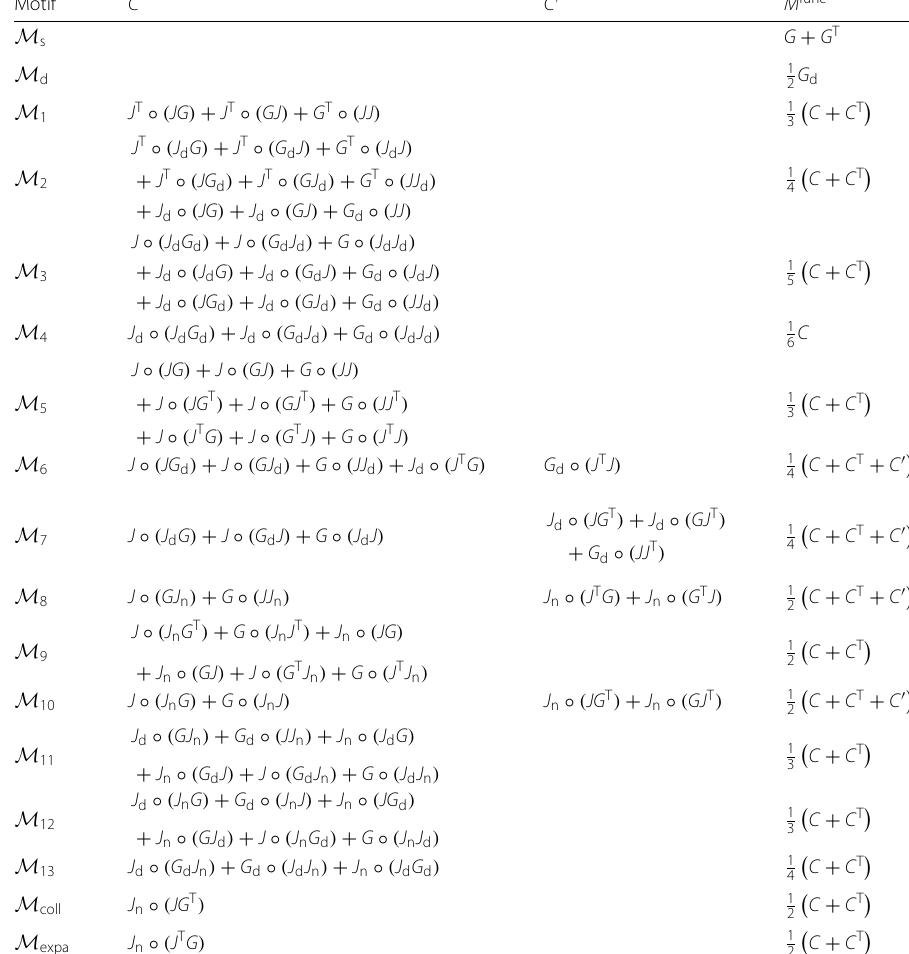
Table 5 Dense formulation of mean-weighted functional motif adjacency matrices